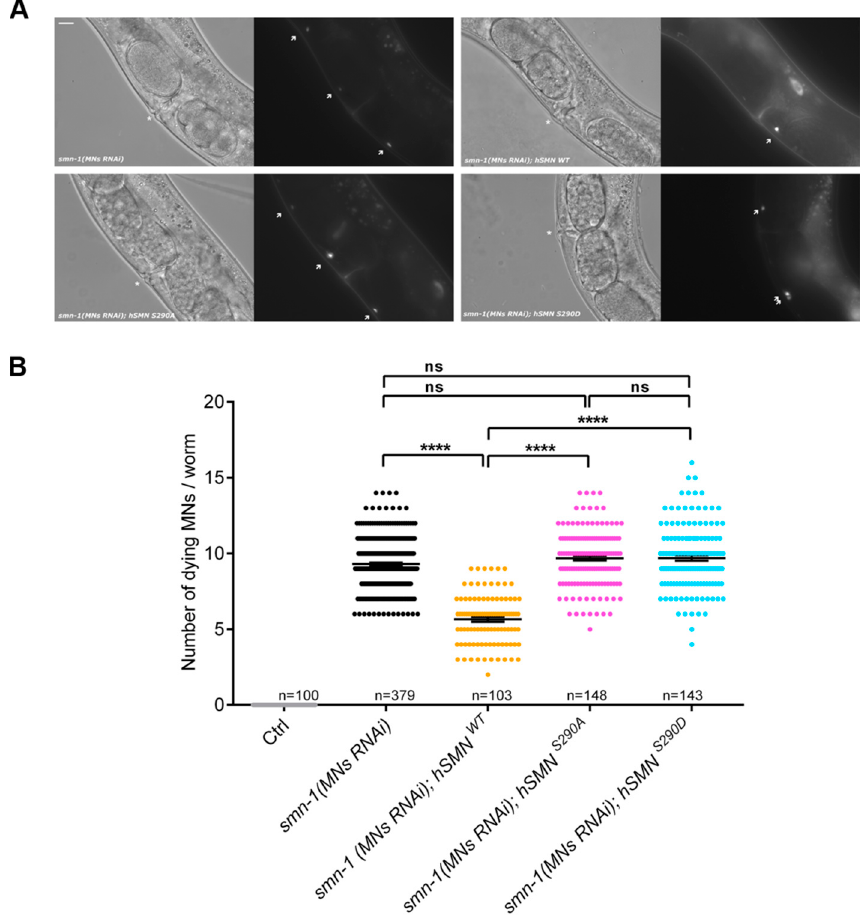
Figure 3. Phosphorylation state of serine residue 290 (S290) a ff ects motoneuron survival in a C. elegans Spinal Muscular Atrophy (SMA) model . ( A ) Representative fluorescence images show dying MNs. smn-1(MNs RNAi); hSMN WT animals (upper right panel) presents less dying neurons (arrows) than smn-1(MNs RNAi) (upper left panel) and smn-1(MNs RNAi); hSMN S290A and smn-1(MNs RNAi); hSMN S290D animals (lower left and right panels, respectively). * indicates the vulva localized at mid-body. Inallpanels, anteriorisleftandventralisdown.Scalebarrepresents10 µ m. ( B )Quantification of the e ff ects of hSMN WT, hSMN S290D, and hSMN S290D on motoneuron survival in a C. elegans SMA model. Each dot represents the number of dying motor neurons in a single animal. The mean number of dying motoneurons and the SEM is also shown. The number of animals scored is annotated (n). One-way ANOVA with Kruskal-Wallis test, **** p < 0.0001, ns = not